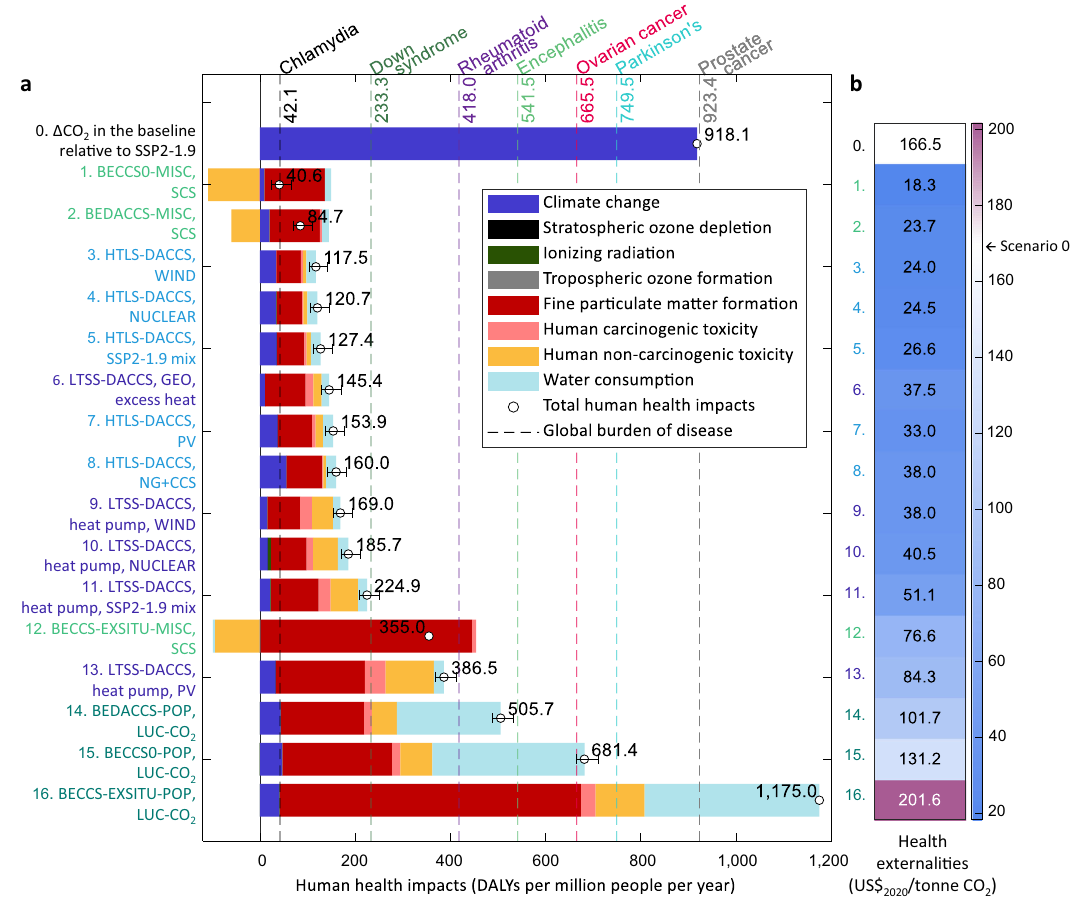
Fig. 3 Health impacts. a Contribution of environmental mechanisms to the total health impacts, expressed in Disability-Adjusted Life Years (DALYs) per million people per year. Scenarios 1 – 16 comprise High-Temperature Liquid Sorbent (HTLS) and Low-Temperature Solid Sorbent (LTSS) Direct Air Carbon Capture and Storage (DACCS) — powered by natural gas with carbon capture and storage (NG + CCS), wind, solar photovoltaic (PV), nuclear, geothermal (GEO), or the global electricity mix deployed in the SSP2-1.9 marker scenario without NETs (which limits the increase in radiative forcing to 1.9 W/m 2 by 2100 and is based on Shared Socioeconomic Pathway 2) — , the basic Bioenergy with Carbon Capture and Storage (BECCS) scenarios (BECCS0) deploying Miscanthus (MISC) or poplar (POP) — assuming either Soil Carbon Sequestration (SCS) or land-use change (LUC) — , the hybrid BEDACCS con fi gurations integrating BECCS0 and LTSS-DACCS, and the BECCS scenarios where CO 2 is mineralized ex situ (BECCS-EXSITU). Scenarios 1 – 16 are ranked by the total health impacts, scenario 1 is the best. We show the global burden of certain diseases in 2019 38 for reference. The black bars indicate the health impact range of the scenarios based on the in situ sequestration options, i.e., geological sequestration at high pressure and mineral carbonation with freshwater (upper bound) or seawater (lower bound). b Health externalities, expressed in US$ 2020 per gross tonne CO 2 captured (scenarios 1 – 16) or emitted (scenario